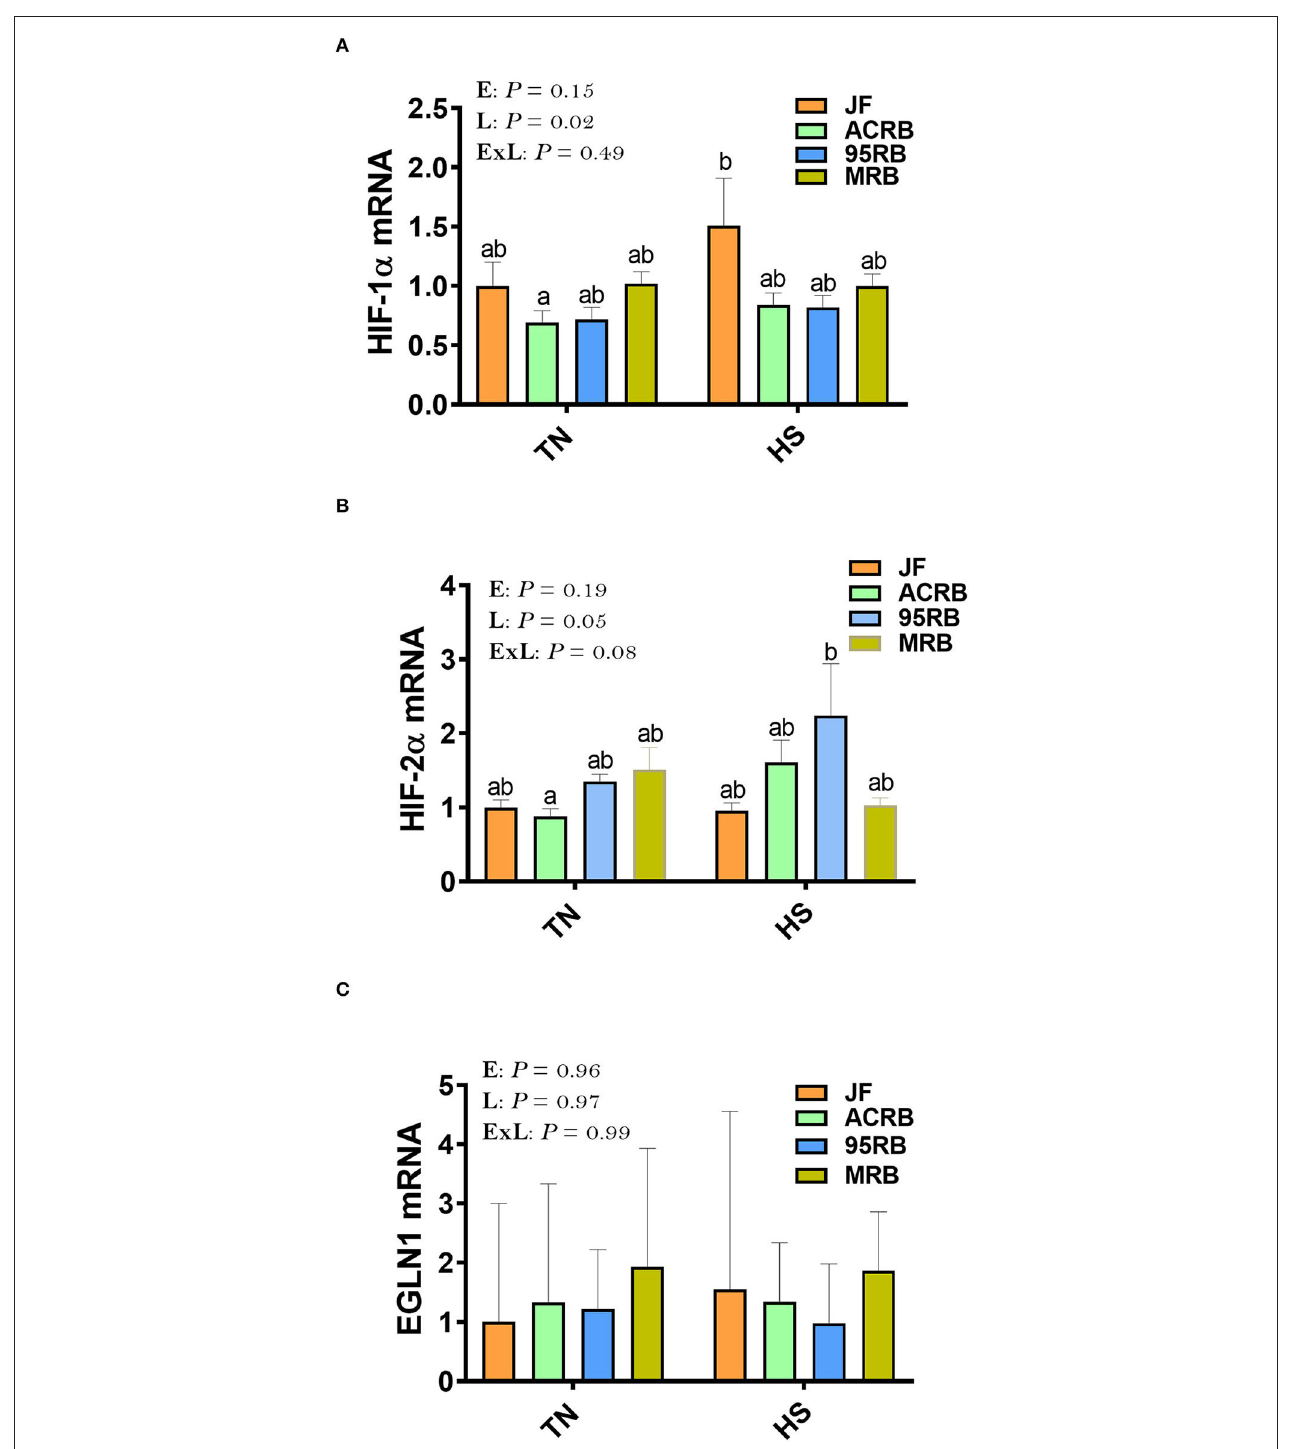
FIGURE 1 | Effect of HS on hypothalamic expression of HIF complex in three modern broilers and their ancestor JF. (A) HIF-1 α , (B) HIF-2 α , and (C) EGLN1. RNA was extracted from hypothalamic tissues and analyzed by qPCR using 2 − 11 CT method (41). Gene expression data are mean ± SEM ( n = 6/group). Different letters indicate significant difference at P < 0.05. 95RAN, 1995 random bred; ACRB, Athens Canadian Random Bred; E, environment; EGNL1, Egl-9 Family Hypoxia Inducible Factor 1; ExL, interaction between E and L; HIF, hypoxia-inducible factor; HS, heat stress (36 ◦ C); JF, jungle fowl; L, line; MRB, modern random bred; TN, thermoneutral (25 ◦